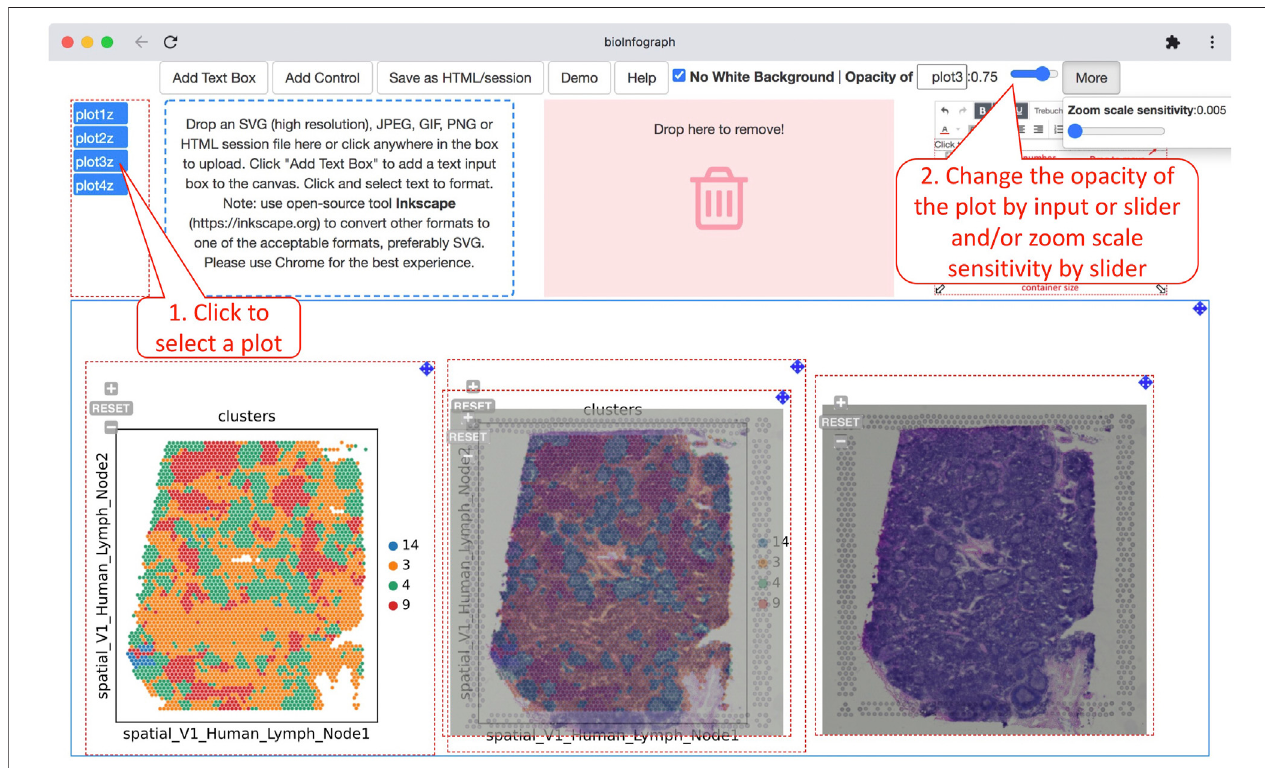
FIGURE 6 | Overlaying colored spatial clustering plot and histological image to illustrate the relationship of histological features and clusters based on 10X Genomicsspatialtranscriptomicsdata(https://bit.ly/3F0xKWD).Userscanadjusttheopacityofaselectedplotbyclickingaplothandletoselecttheplotandthentyping a number or using the slide to change the value. The zoom scale sensitivity of the plot is tuned to the smallest number for fi ne alignment of overlaid